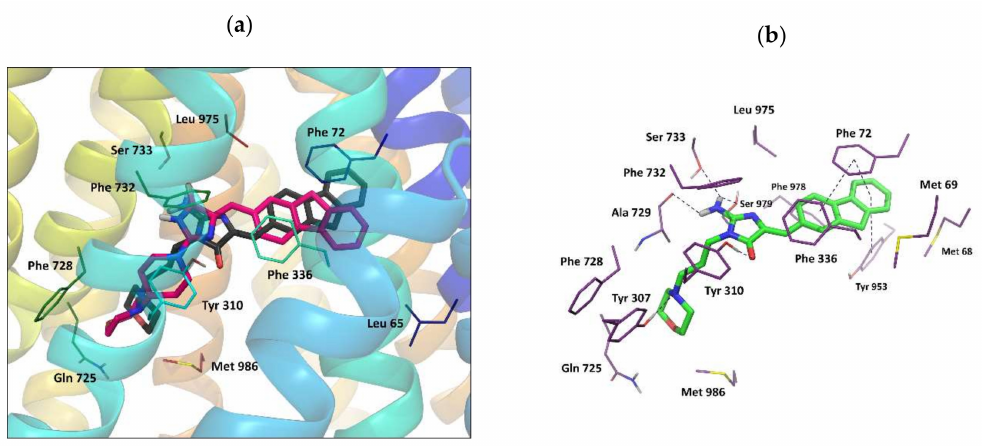
Figure 5. ( a ) Binding mode of compounds 18 and 12 adopting docking pose 1; ( b ) molecular interactions for the best docking pose 1 represented by compound 18 .